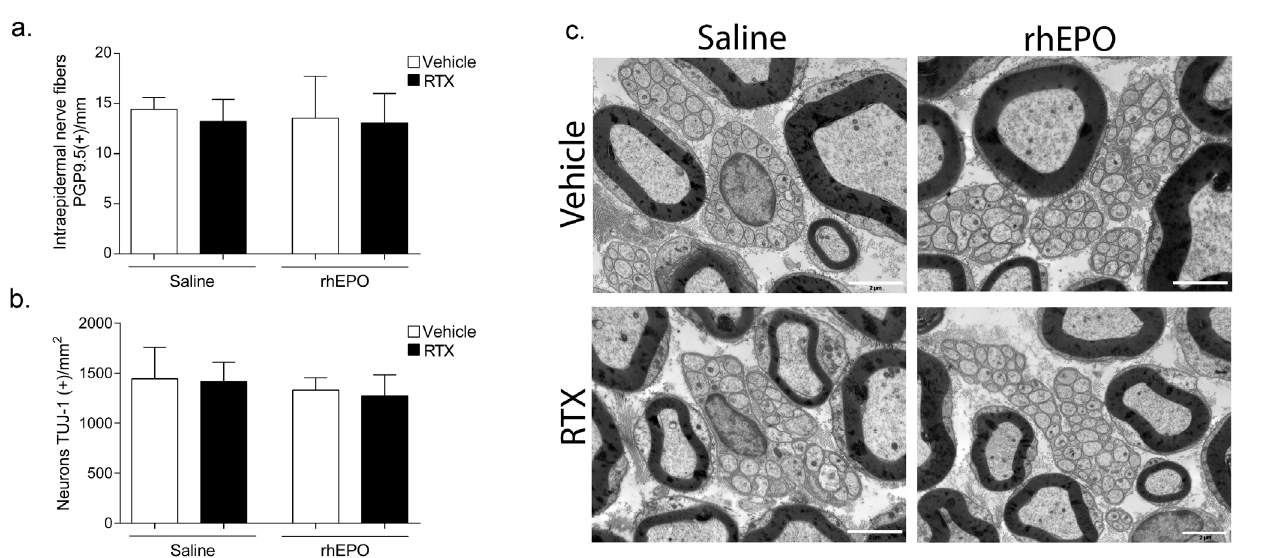
Figure 3. Effects of RTX and rhEPO on unmyelinated nerve fiber and DRG neurons. ( a ) Foot pad skin and DRG neurons were immunostained for protein gene product 9.5 (PGP9.5). Quantification of intraepidermal nerve fiber positive for PGP9.5. The density of intraepidermal nerve fibers was calculated according to ENFS guidelines [33]. (n 5 6 in each group). ( b ) Quantification of DRG neurons positive for PGP9.5. The density of neurons was expressed as neurons/square millimeter (n 5 12 in each group). ( c ) Unmyelinated nerve fiber morphology in sciatic nerve was examined by electron microscopy. Scale bar 5 2 m m. DRG: dorsal root ganglia, rhEPO: recombinant human erythropoietin, RTX: resiniferatoxin.